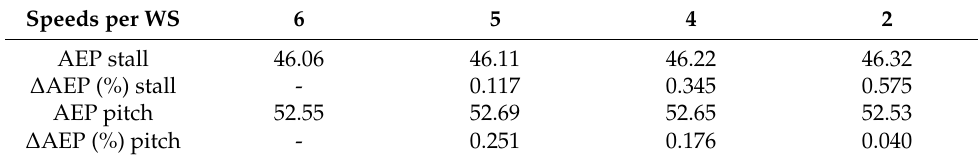
Table 4. Statistical convergence of annual energy production (AEP).